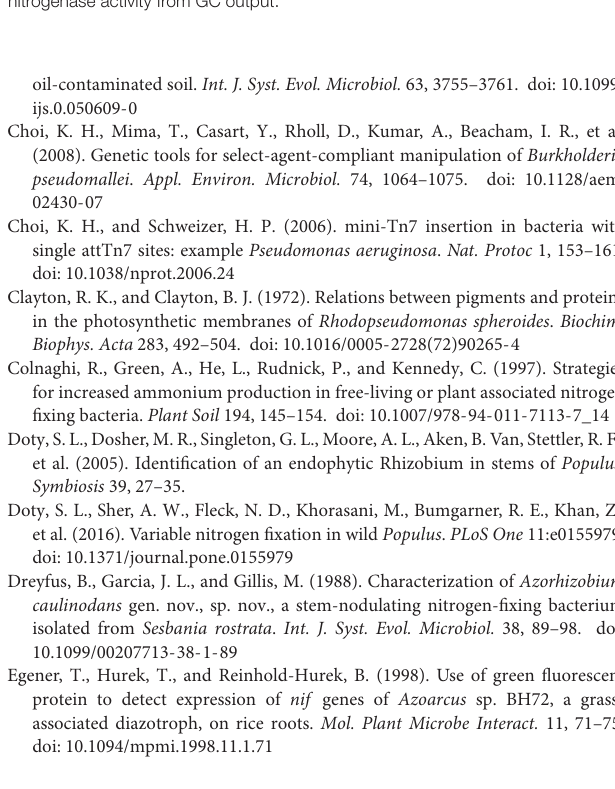
Supplementary Figure 2 | Flow-cytometry gating strategy to assess P nifH expression by bacteria re-isolated from in situ ARAs. Using the CellStream R (cid:13)